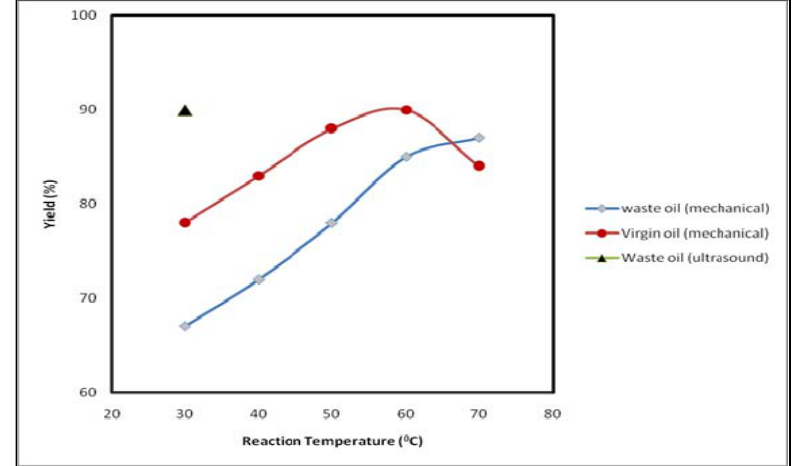
Figure 5. Effect of reaction temp. on FAME yield via the ultrasound and mechanical stirring under a 6:1 methanol/oil ratio at 30 °C and catalyst concentration of 0.75% wt/wt and 1% wt/wt,